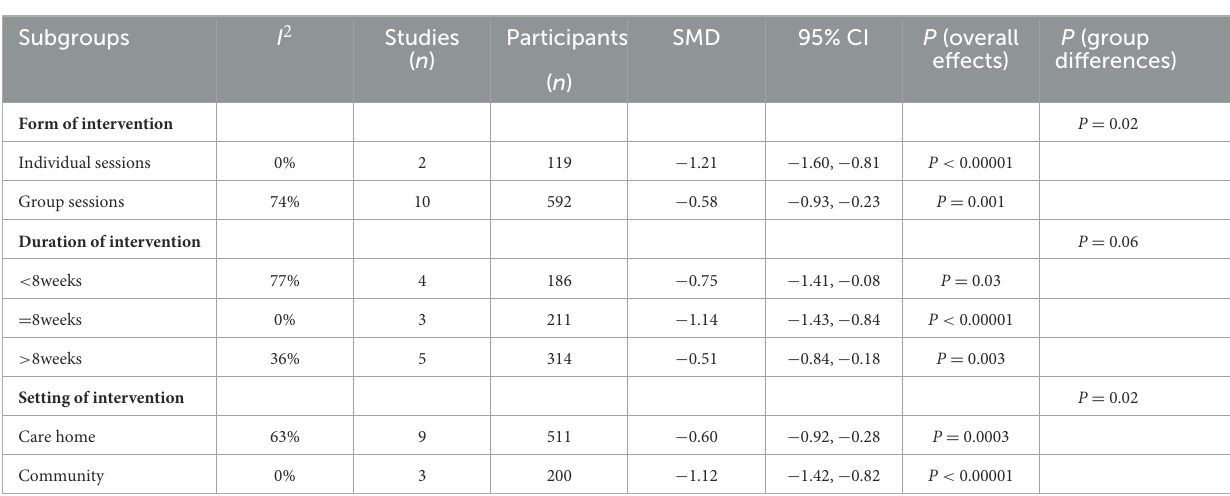
TABLE 2 Results of subgroup analysis of